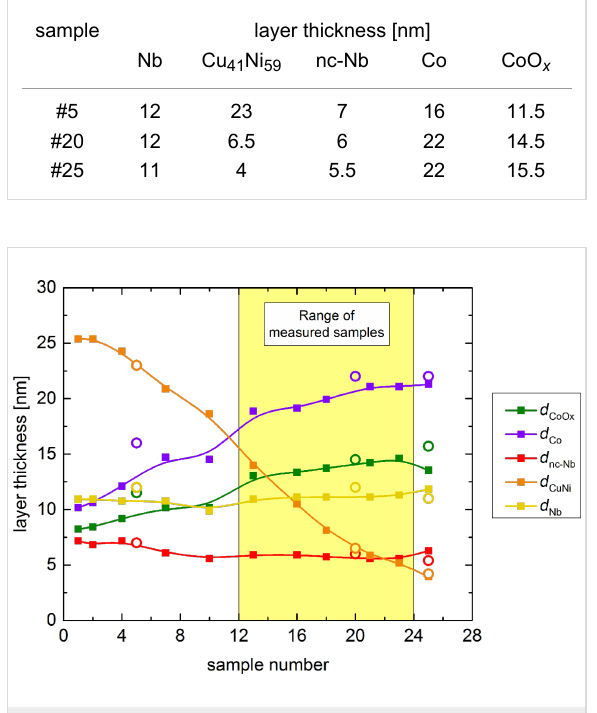
Table 1: Layer thicknesses of several samples of the investigated sample series SF 1 NF 2 -AF1 as obtained by a cross-sectional TEM in- vestigation. Please note, that the thicknesses given are evaluated over a larger range than shown in Figure 2.